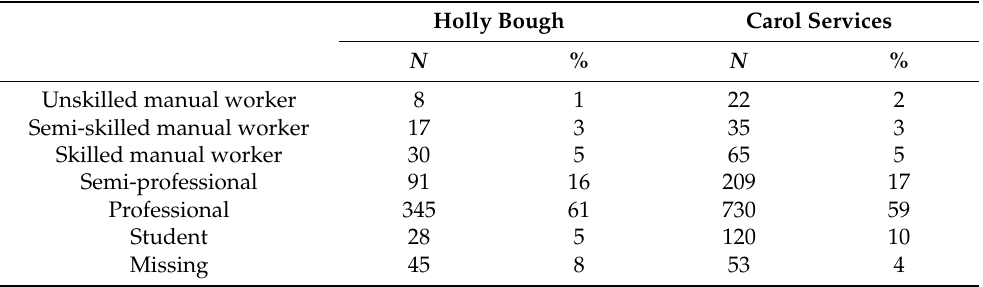
Table 4. Type of work.